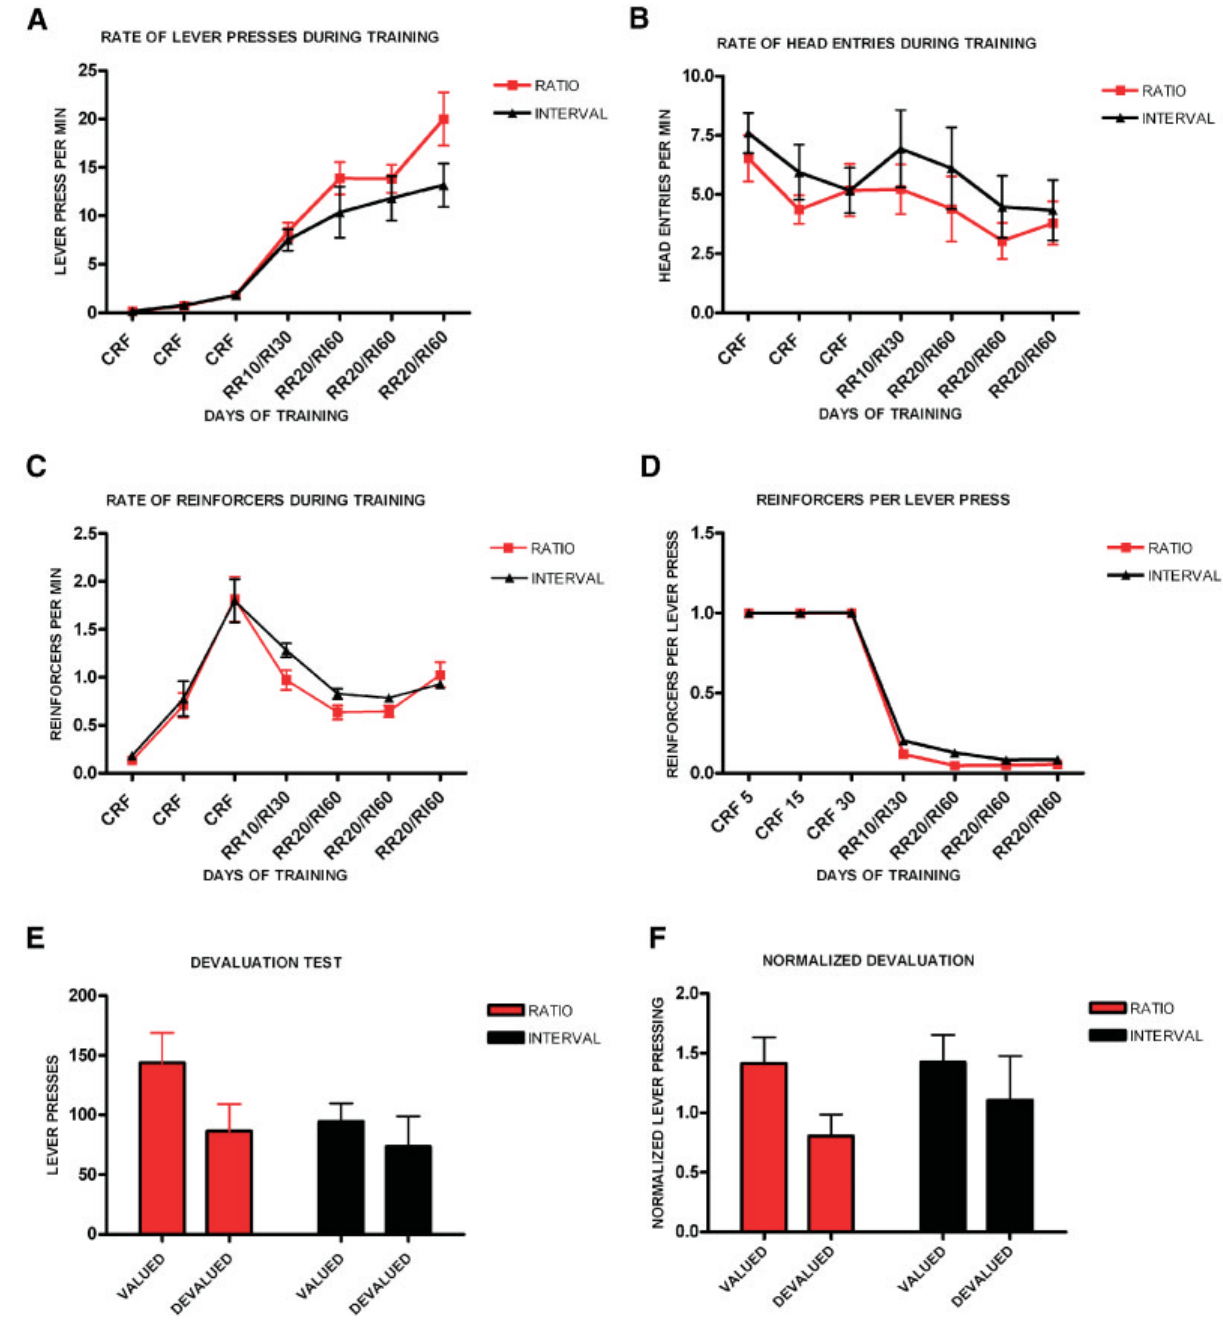
Figure 1. Different schedules of reinforcement produce different predisposition to habit formation in C57B16/J mice . ( A ) Acquisition of the lever-pressing task in animals trained on random ratio and random interval schedules. The rate of lever pressing (per minute) for each daily session is depicted. ( B ) Average rate of head entry throughout training for the random interval and random ratio groups. ( C ) Average rate of reinforcement throughout training for the random interval and random ratio groups. ( D ) Rate of reinforcement per lever press throughout training for the random interval and random ratio groups. ( E ) Absolute number of lever presses during the valued versus the devalued condition for the different training schedules. ( F ) Lever pressing during the valued versus the devalued condition normalized to the lever pressing of the last day of training.